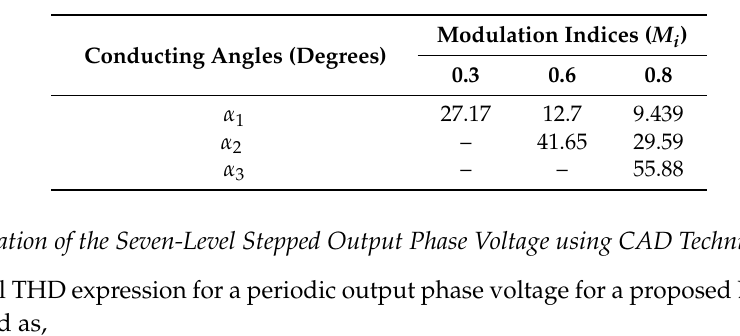
Table 5. Conducting angles of SPWCAD technique for various M i .